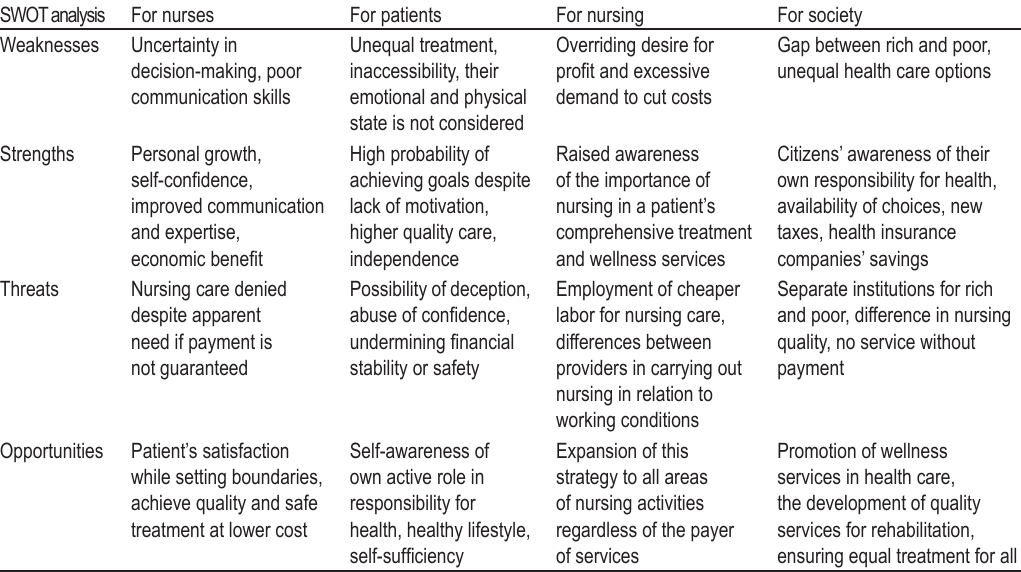
TABLE 2. SWOT analysis according to identified characteristics of hotel‑type nursing SWOT